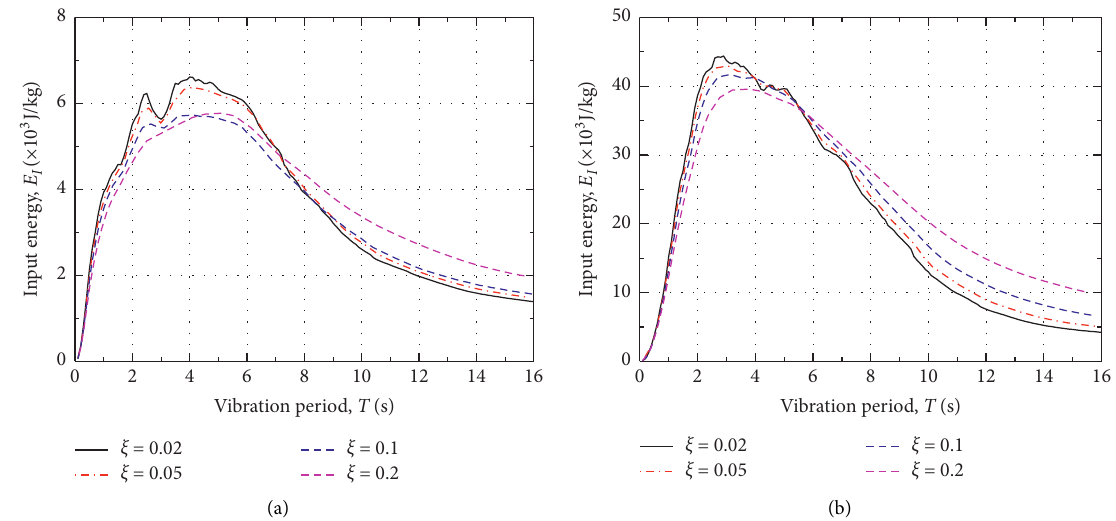
Figure 13: Input energy spectra affected by damping ratio. (a) Near-fault pulse-like ground motions. (b) Far-field harmonic ground